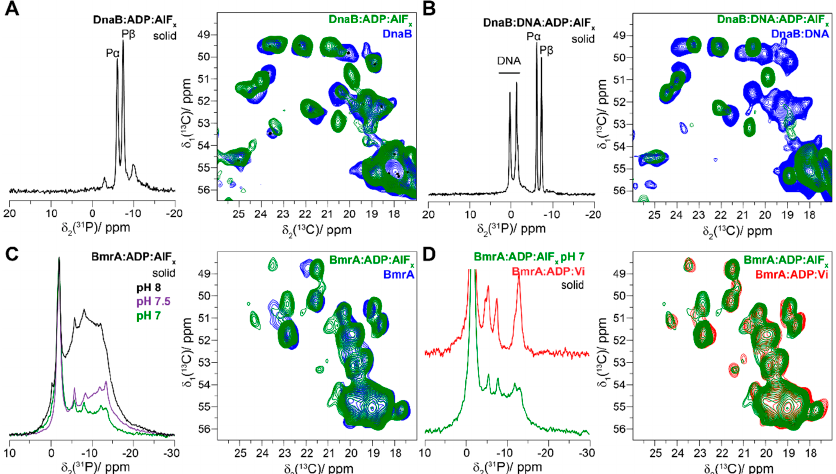
Figure 9. Comparison of the metal fluoride AlF x on the systems BmrA and DnaB. 1D CP of